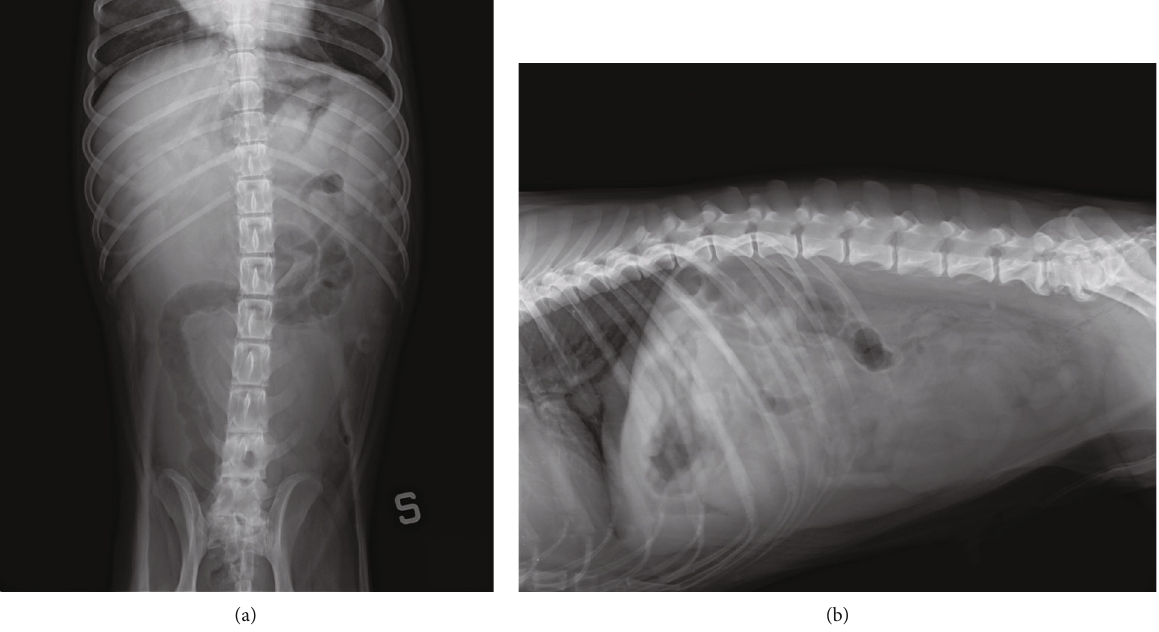
Figure 1: Abdominal plain radiographs: (a) ventrodorsal projection showing the large structure with a liquid-like radiopacity occupying a large part of the middle and caudal abdomen; right dislocation of the middle and distal portions of the descending colon (S indicates the left side); (b) right lateral projection showing the large and convolute structure localized cranially and dorsally to the urinary bladder; lumbosacral transitional vertebra and spondylosis in L6, L7, and S1.